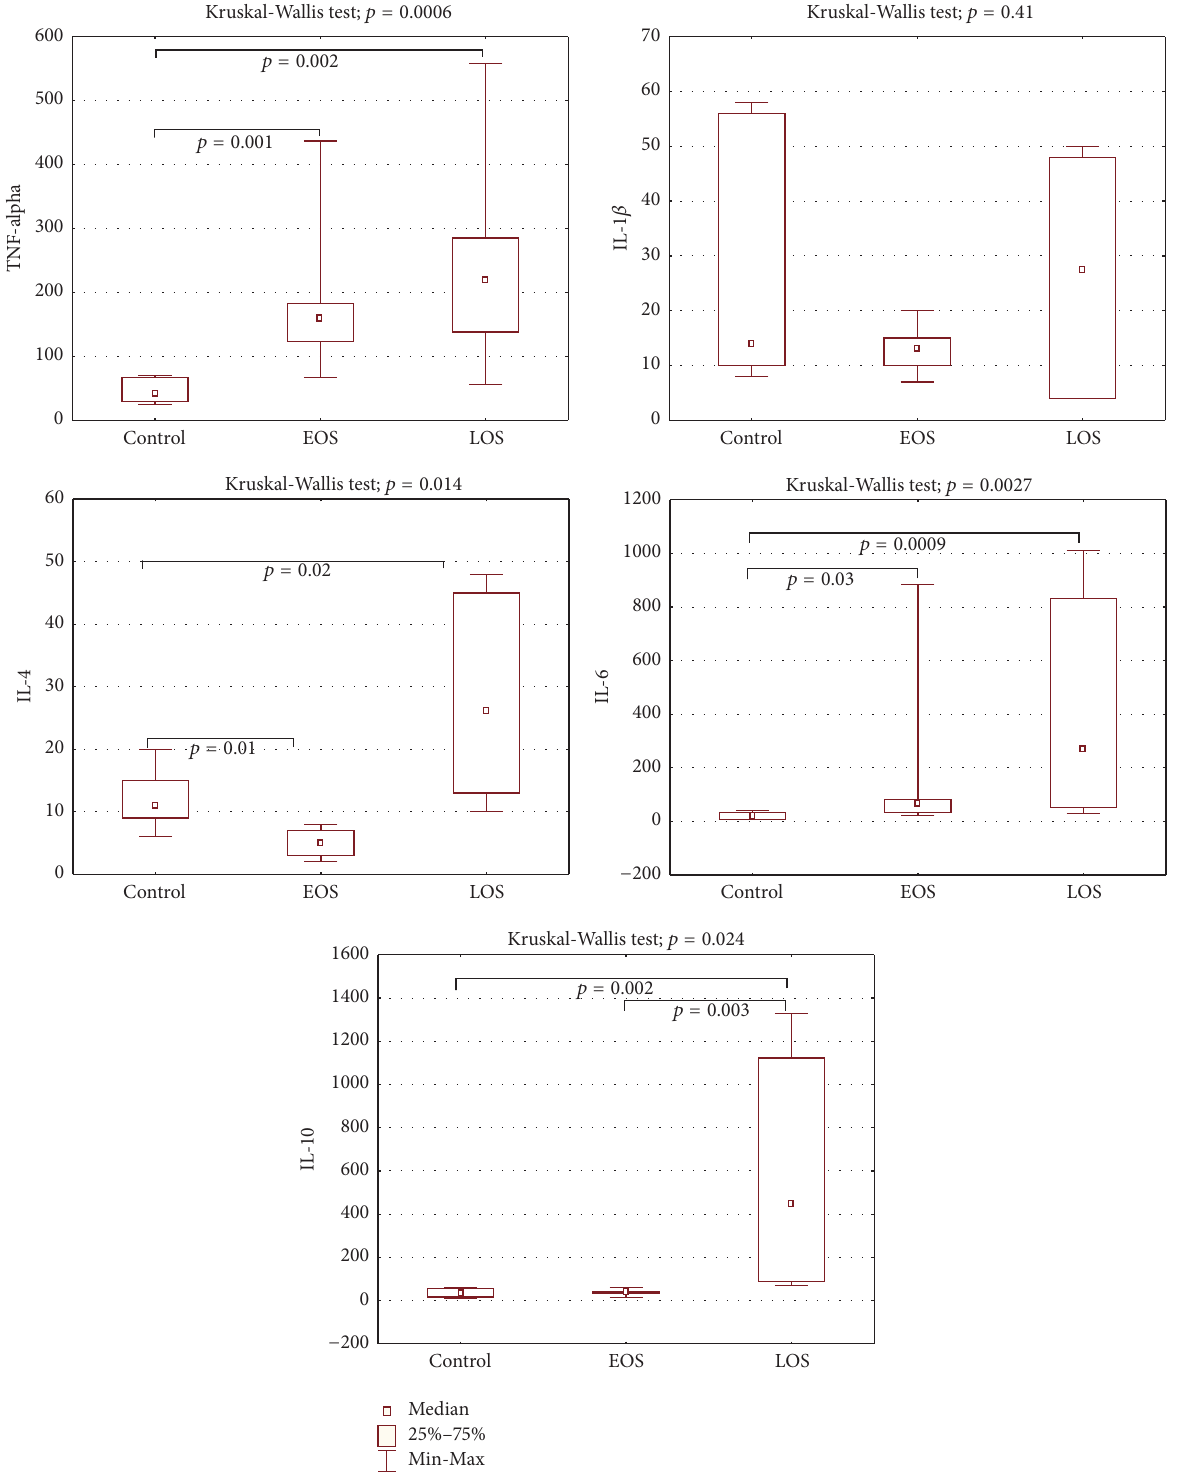
Figure 1: Serum cytokine level (pg/mL) in EOS and LOS types of neonatal sepsis (mean; quartile range). Kruskal-Wallis test was performed for comparison of control group and neonates with EOS and